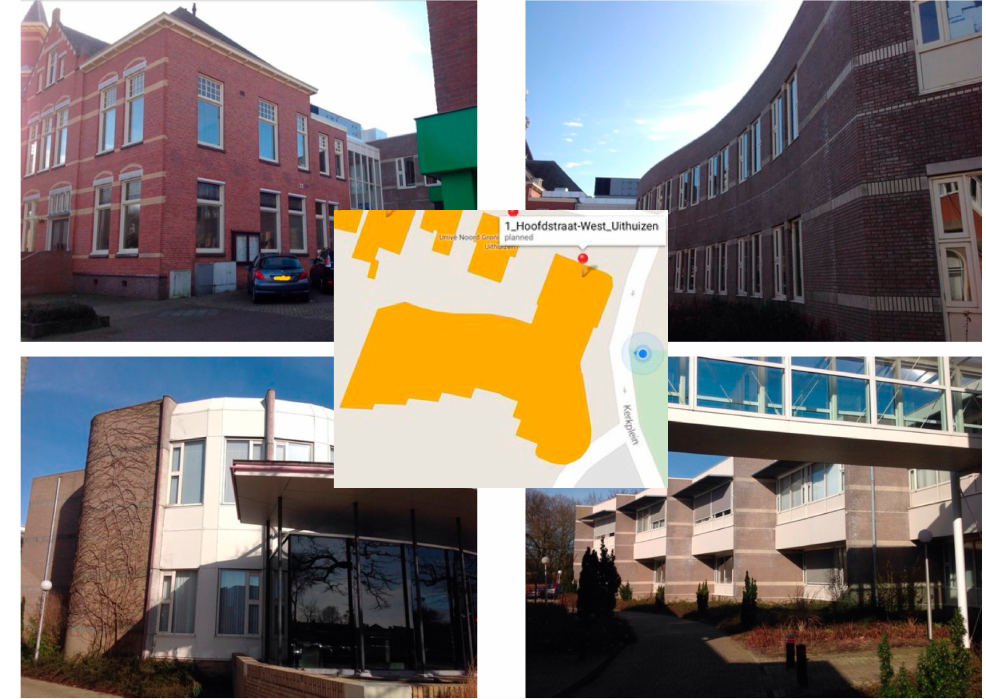
Figure 1. Building with basement case study (Arup, 2015) [13].